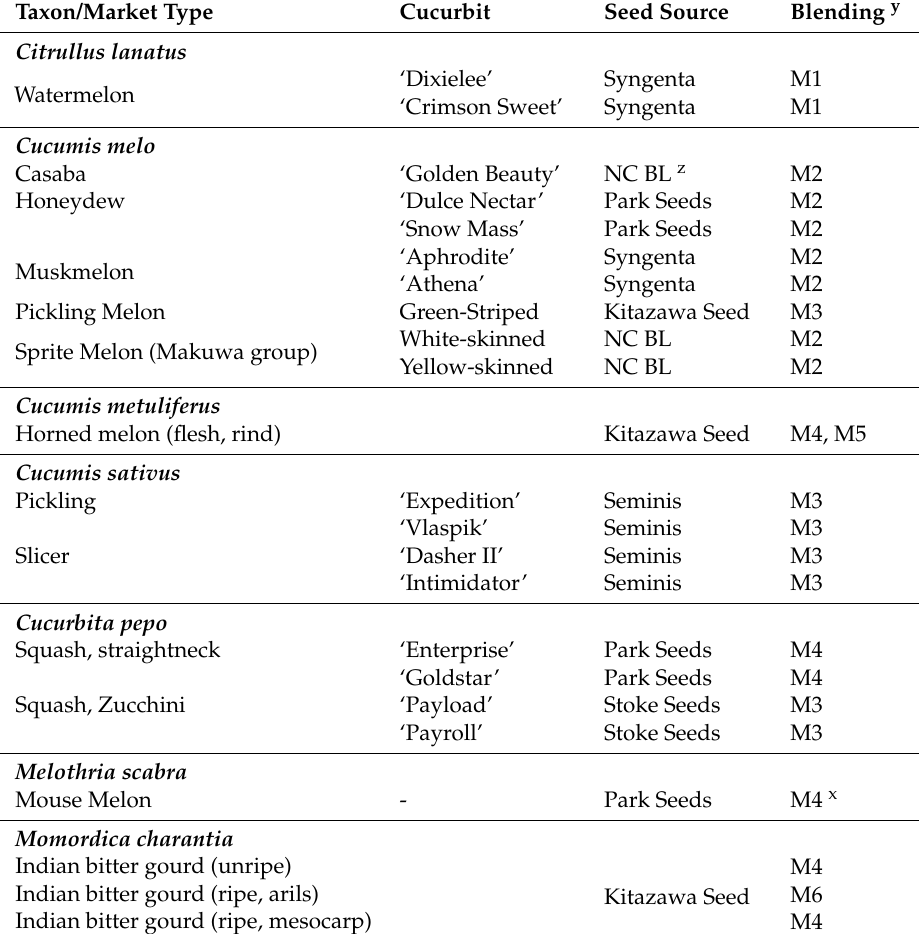
Table 1. Cucurbits evaluated, including seed source and blending